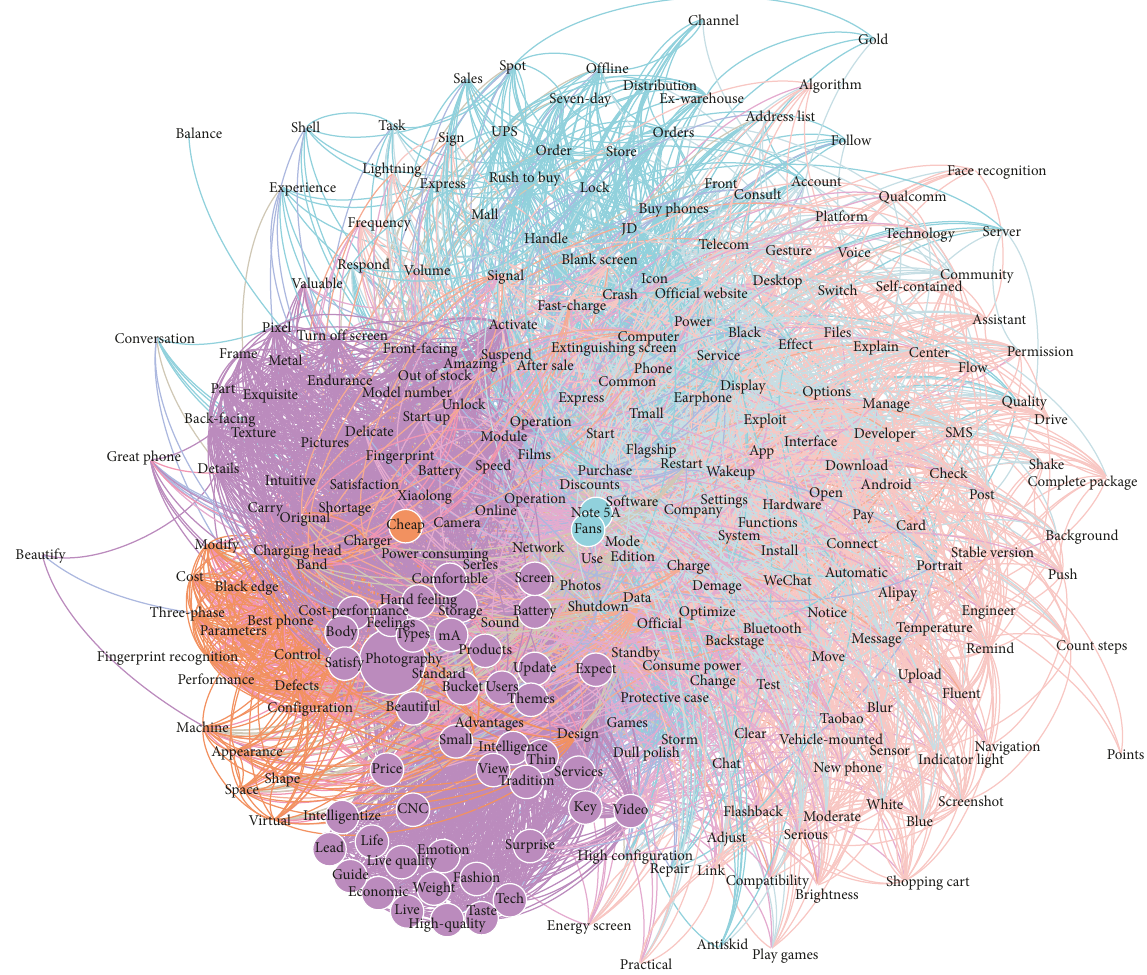
Figure 14: Visualized co-creation knowledge network. Table 8: Example of some extracted product features and their